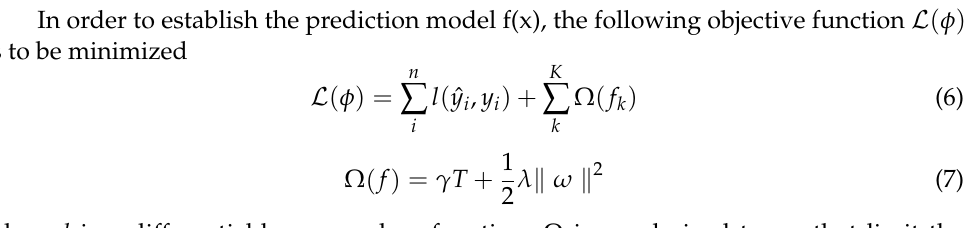
Figure 5. Illustrations of the ( a ) CART model and ( b ) boosting ensemble trees [46,47].